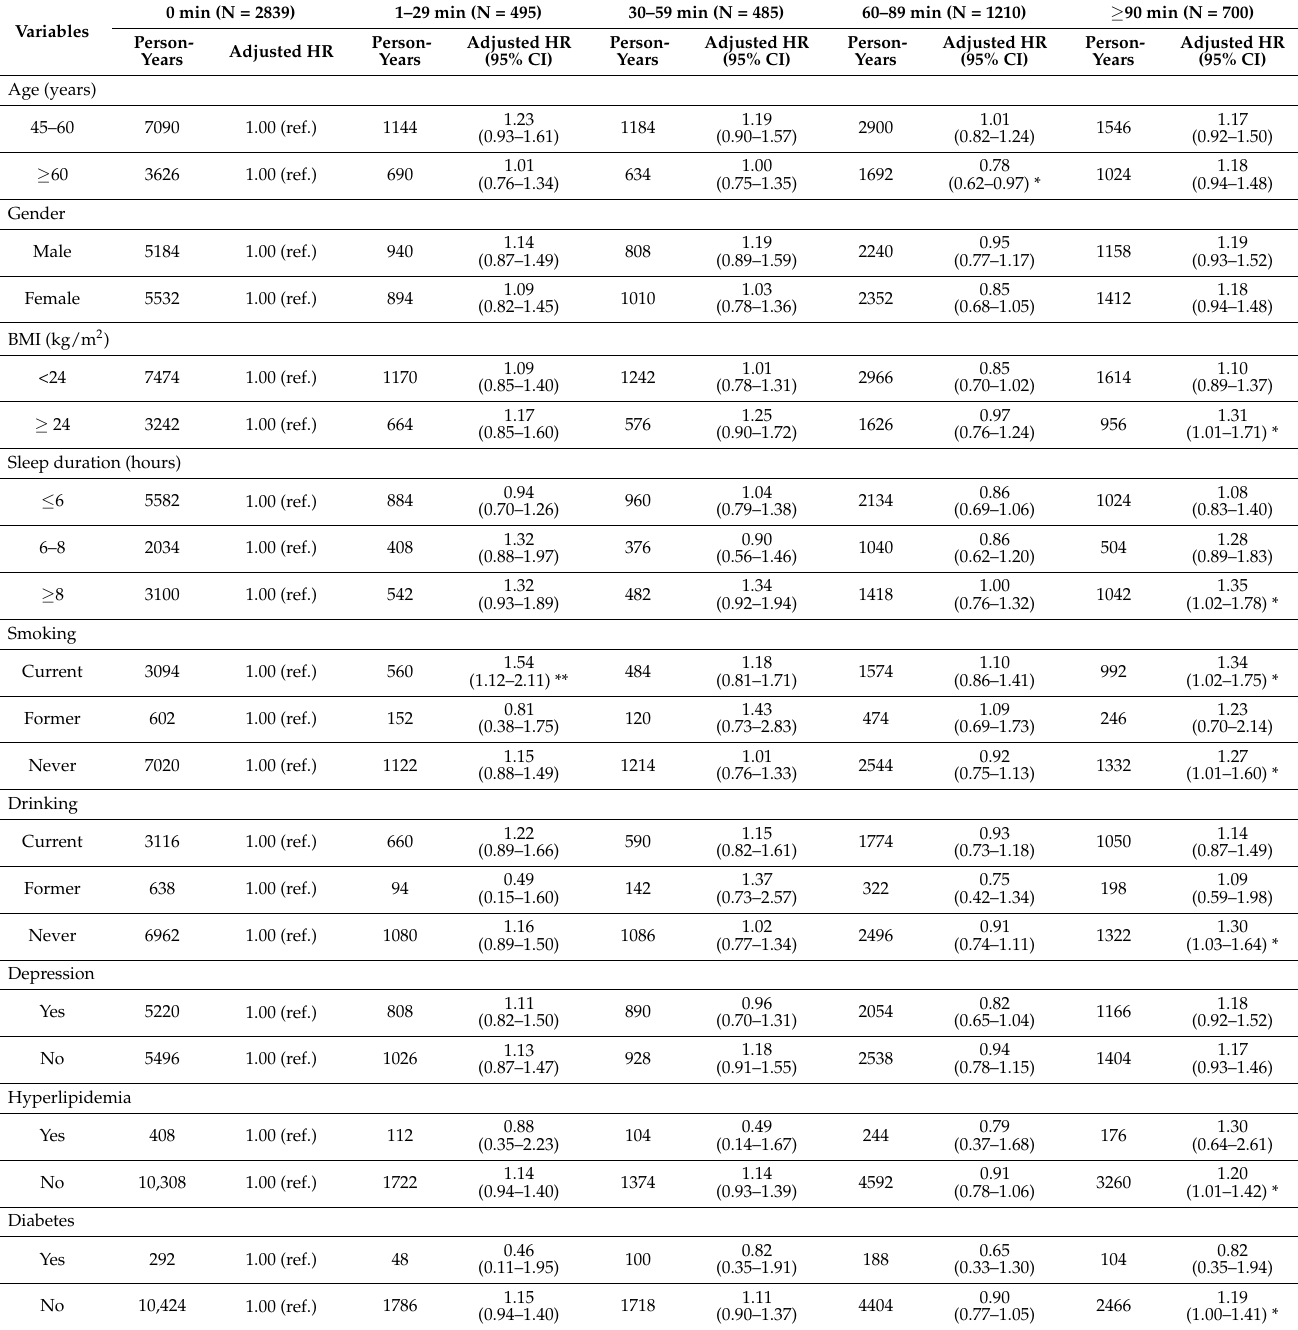
Table A1. Hypertension risk and midday napping, stratified by baseline